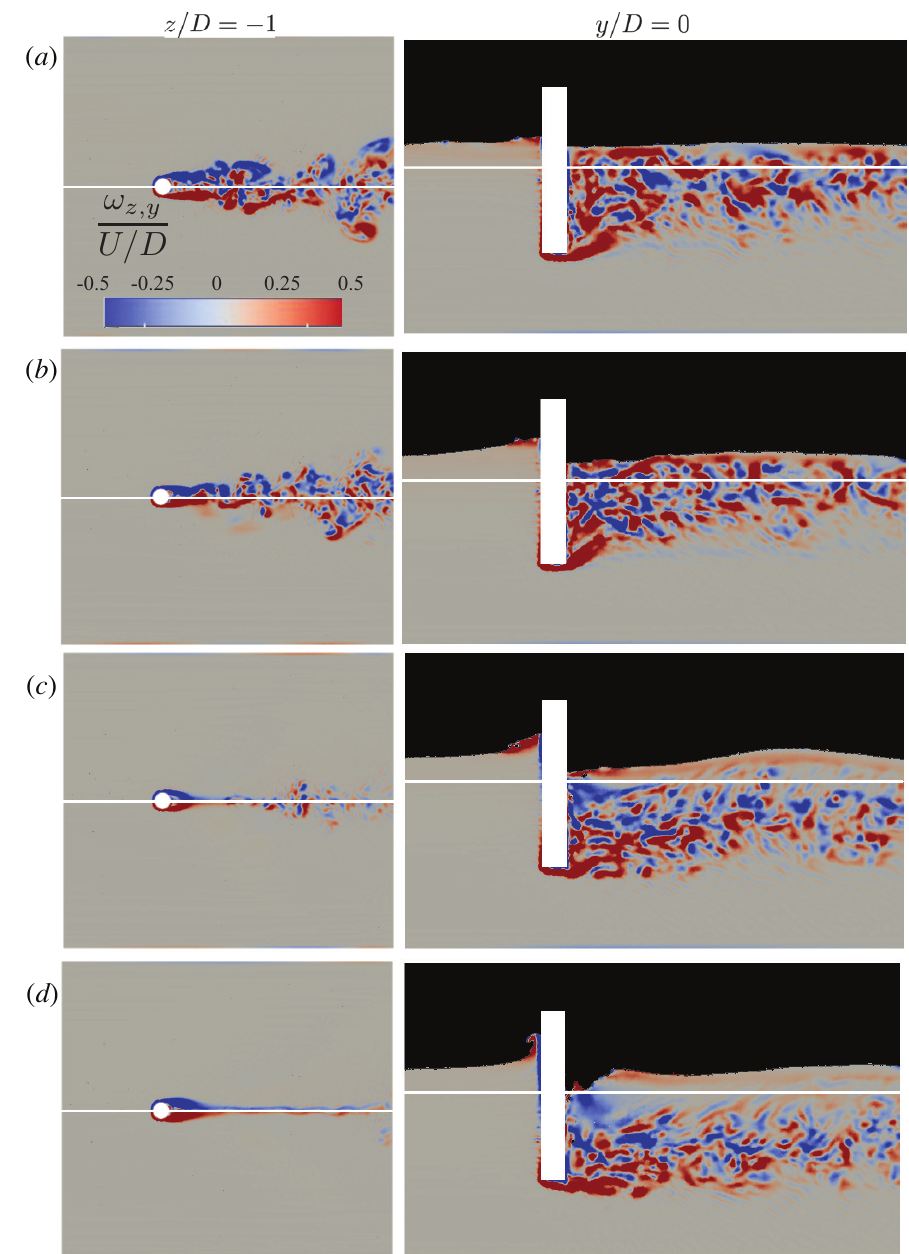
Figure 3. Instantaneous normal vorticity component at Ut / D = 60 for D = 5 cm. ( a ) Re = 30,000, Fr = 0.86; ( b ) Re = 45,000, Fr = 1.28; ( c ) Re = 55,000, Fr = 1.57; and ( d ) Re = 70,000, Fr = 2. The white line in the horizontal planes, z / D = − 1, indicates the vertical plane. In the vertical planes, y / D = 0, the white line represents the horizontal